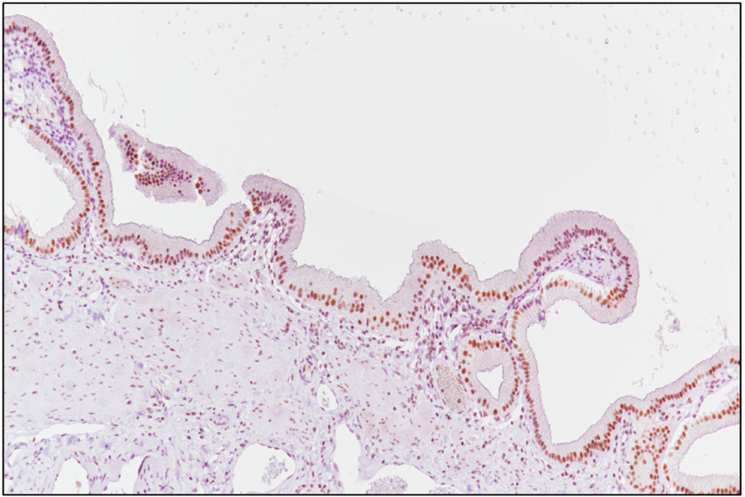
Figure 1. Unaffected gallbladder mucosa served as a positive control for SRSF1 (immunoperoxidase staining; original magnification 150 ×